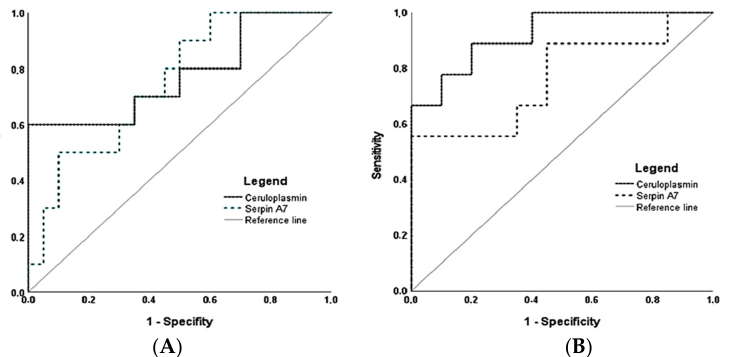
Figure 6. Receiver operating characteristic (ROC) curves for the prediction of preeclampsia and/or fetal growth restriction based on ceruloplasmin and serpin A7 proteins measured by targeted pro- teomics in urine of women at 20–24 and 30–34 weeks of gestation. The ROC curves present the pre- dictive values of ceruloplasmin and serpin A7 measurements using targeted proteomic on maternal urine samples collected at 20–24 weeks of gestation ( A ) and at 30–34 weeks of gestation ( B ). The area under the ROC curves (AUC) were significant for ceruloplasmin at 20–24 weeks (AUC: 0.78; 95%CI: 0.58–0.97, p = 0.016); serpin A7 at 20–24 weeks (AUC: 0.75; 95%CI: 0.57–0.92, p = 0.028); ceruloplasmin at 30–34 weeks (AUC: 0.92; 95%CI: 0.82–1.00, p < 0.001); serpin A7 at 30–34 weeks (AUC: 0.77; 95%CI: 0.56–0.98, p = 0.024).